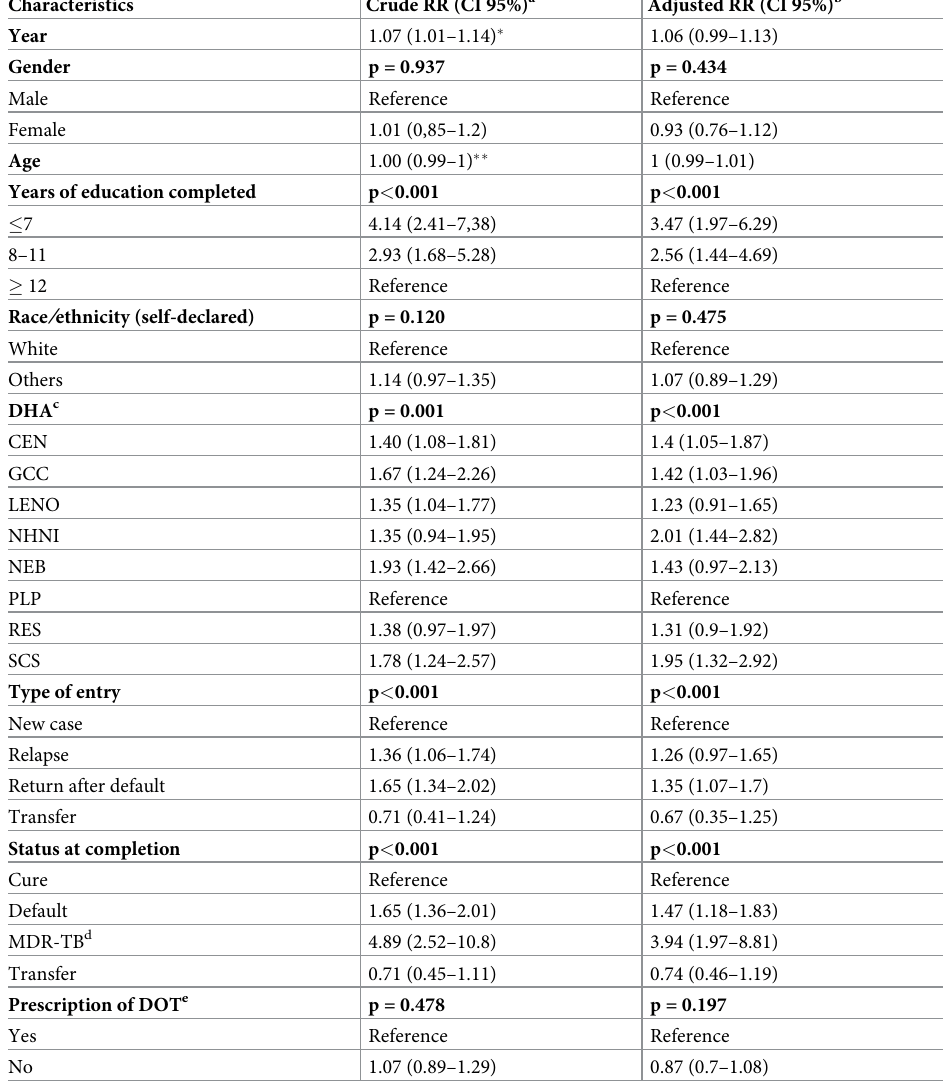
Table 2. Risk factors for hospitalization in cases of TB/ HIV co-infection in Porto Alegre, from 2009 to 2013.